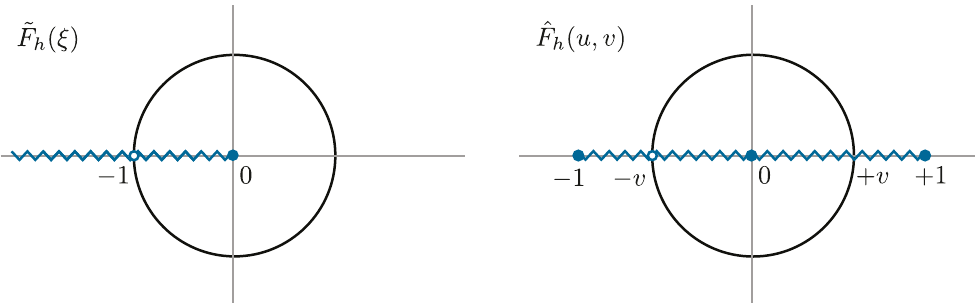
Figure 7. Illustration of the analytic structures of the functions ~ F h ( (cid:24) ) ( left ) and ^ F h ( u; v ) ( right ). where the ellipses denote less singular terms, and we have introduced A (cid:13)at = 1 to keep track of the expected dependence on the scattering amplitude. 15 The (cid:12)rst derivative of (3.53) is ~ F 0 < = (cid:0) A (cid:13)at log (cid:14) + (cid:1) (cid:1) (cid:1) , which at (cid:24) = (cid:0) 1, has the following